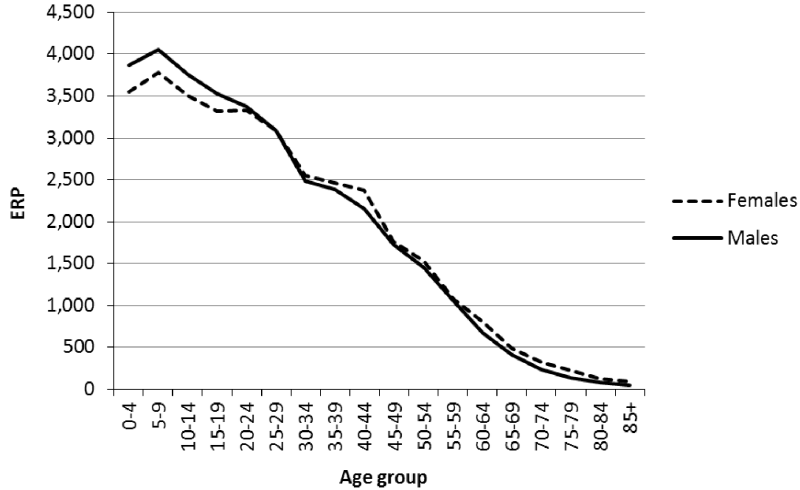
Figure 2. Indigenous Estimated Resident Populations for the Northern Territory, 2011. doi:10.1371/journal.pone.0097576.g002 PLOS ONE |